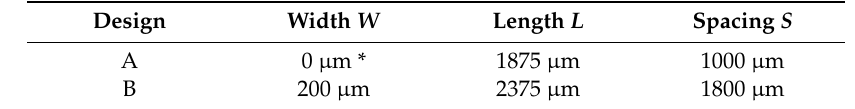
Table 2. Summary of nominal design parameters for the critical interdigitated electrodes (IDE) finger dimensions.